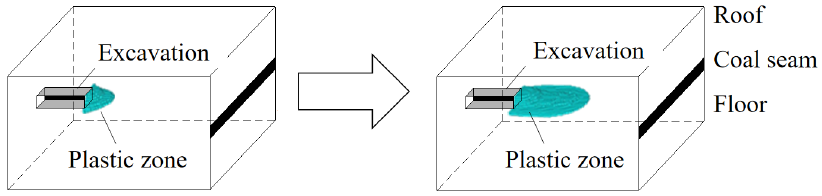
Figure 8. The expansionary evolution of the plastic zone in event Ⅲ .